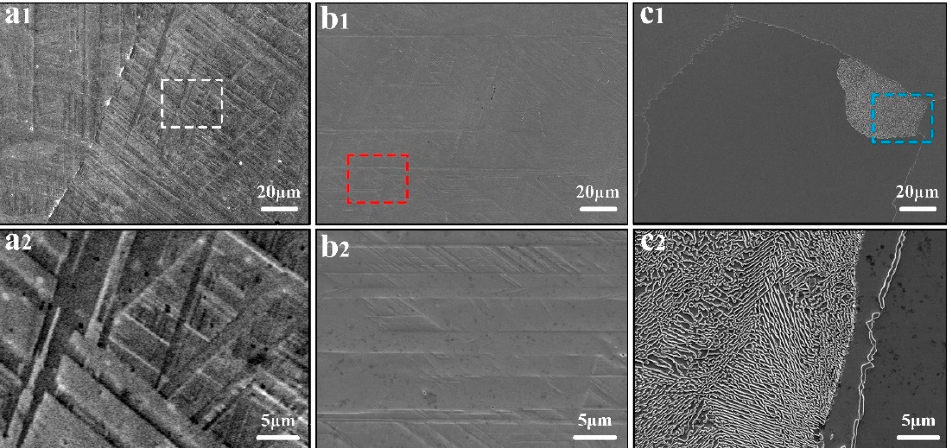
Figure 2. SEM images of the as-cast Fe50Mn30Co10Cr10 alloys with different carbon contents: ( a ) 0C-AC, ( b ) 0.2C-AC, ( c ) 0.5C-AC; ( a 2), ( b 2) and ( c 2) are magnified maps of the selected region in ( a ) 0C-AC, ( b ) 0.2C-AC, ( c ) 0.5C-AC; ( a2 , b2 , c2 ) are magnified maps of the selected region in ( a1 , b1 , c1 ( a 1), ( b 1) and ( c 1).